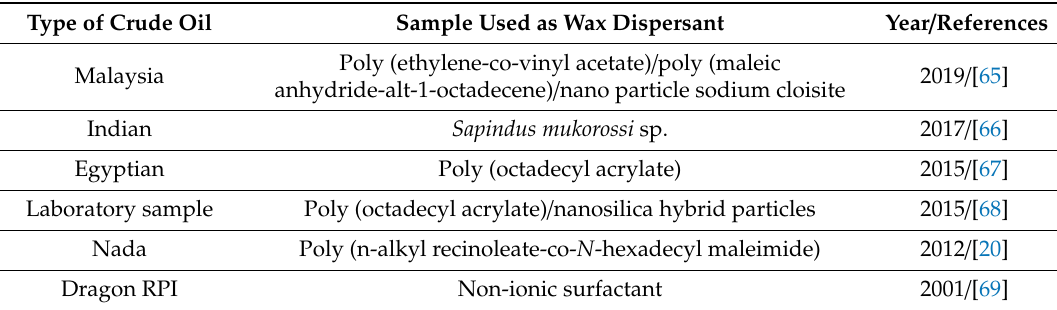
Table 2. Examples of wax dispersant used in deposition studies.